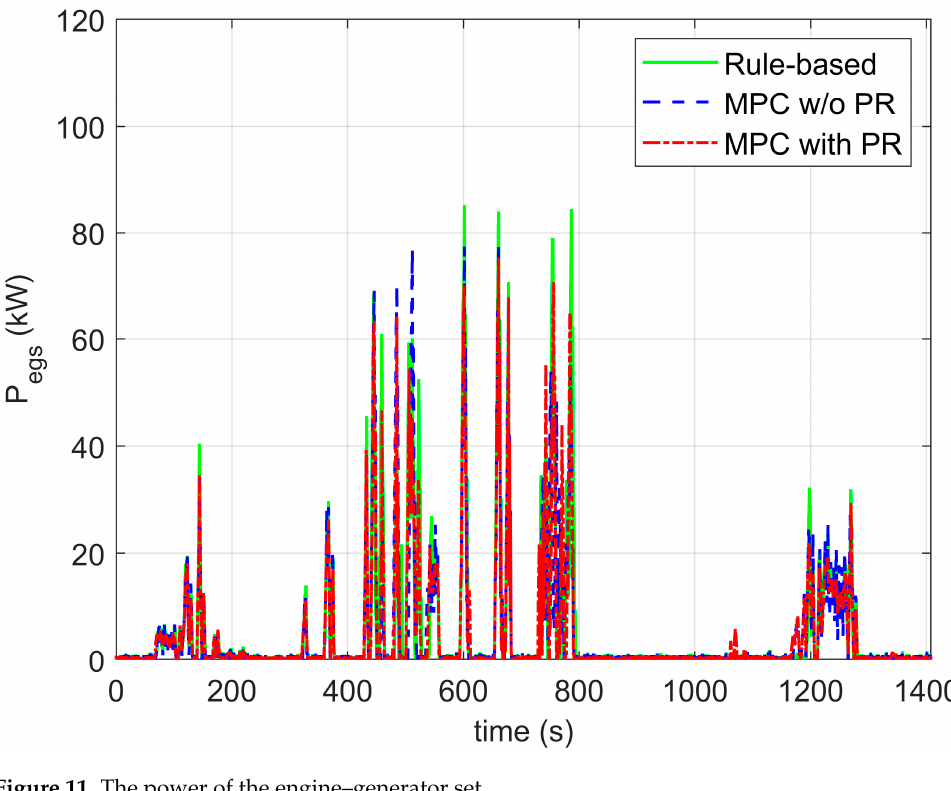
Figure 11. The power of the engine–generator set.